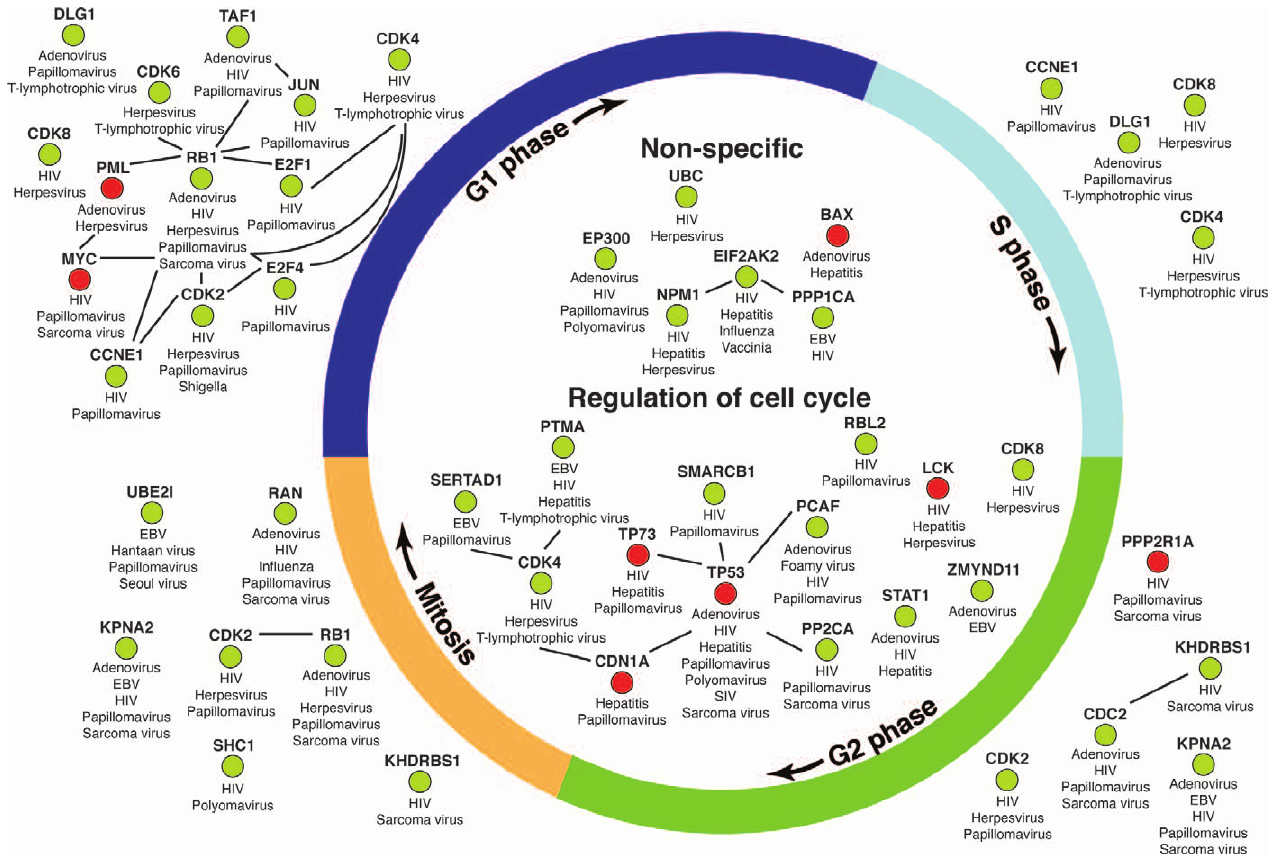
Figure 4. Human Cell Cycle Proteins Interacting with Multiple Viral Pathogen Groups Enriched network of human proteins annotated with ‘‘ cell cycle. ’’ The subset of proteins labeled as ‘‘ Non-specific ’’ are those not annotated with any function more specific than ‘‘ cell cycle ’’ in GO. If a protein participates in multiple phases, then it appears in each phase. An edge connecting two proteins denotes a known interaction in the human PPI network. Human proteins highlighted in red are those known to be involved in the induction of apoptosis.